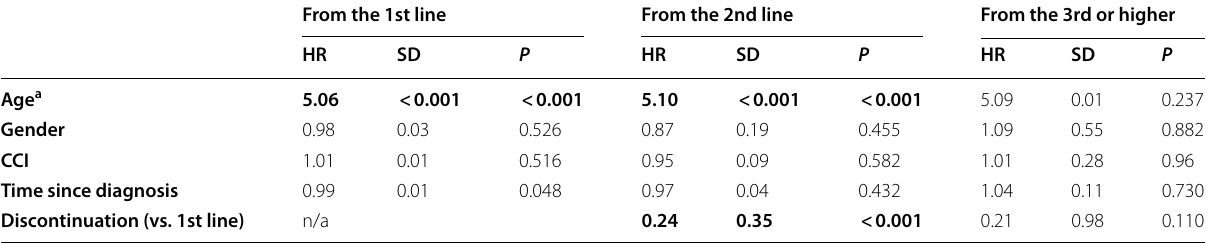
CCI Charlson Comorbidity Index, HR hazard ratio, n/a not applicable, SD standard deviation, Pp -value